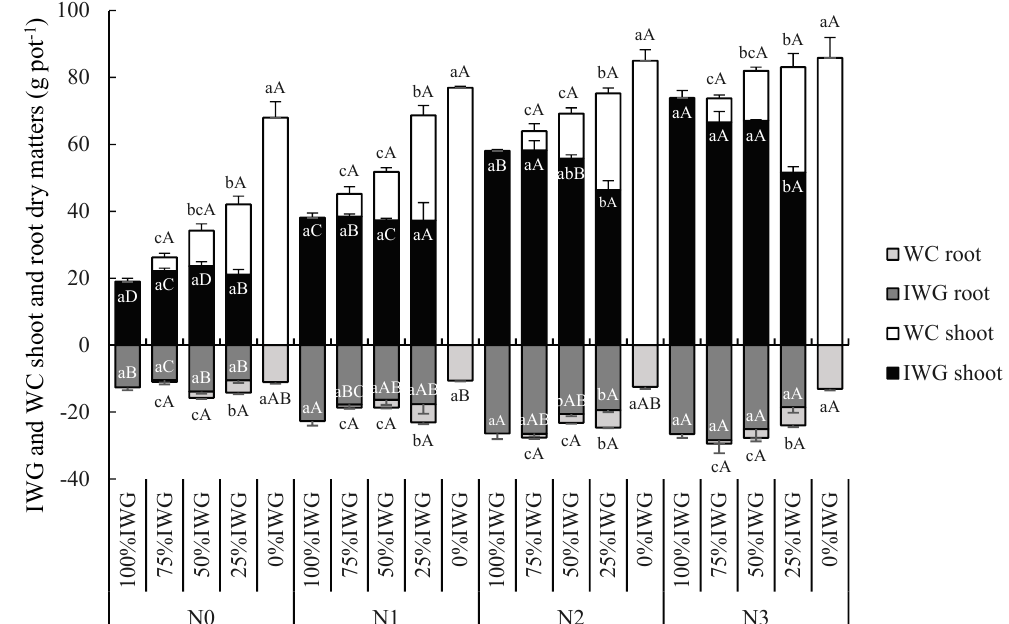
Figure 1. Shoot and root dry matter of intermediate wheatgrass (IWG) and white clover (WC) per pot under four N ferti- lizer levels (N0, N1, N2, and N3) and five IWG-relative frequencies (IRF) (100% IWG, 75% IWG, 50% IWG, 25% IWG, 0% IWG). The absolute values of numbers on the negative side of the Y -axis are the root dry matter of IWG and WC. Different lower-case letters indicate significant differences at p < 0.05 among IRF under the same N level, and different upper-case letters indicate significant differences at p < 0.05 among N levels under the same IRF (Tukey’s post hoc test).